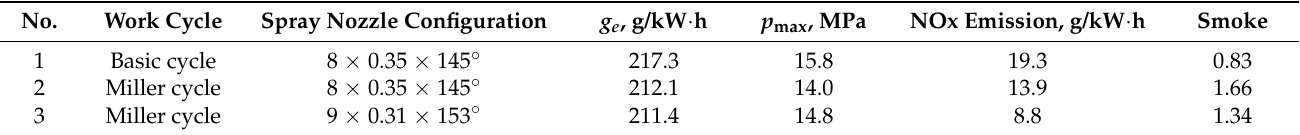
Table 4. Test results of a diesel ICE with different working cycles, nozzle atomizer designs and a new HPFP drive.